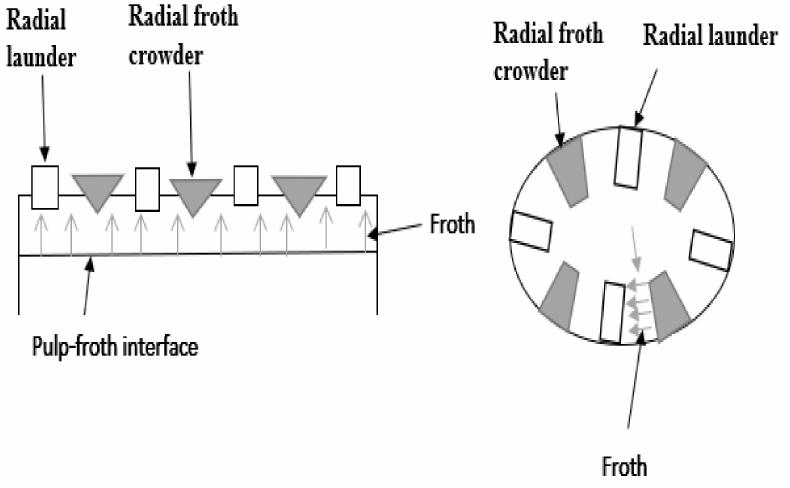
Figure 16. Cut and top section of radial froth crowders